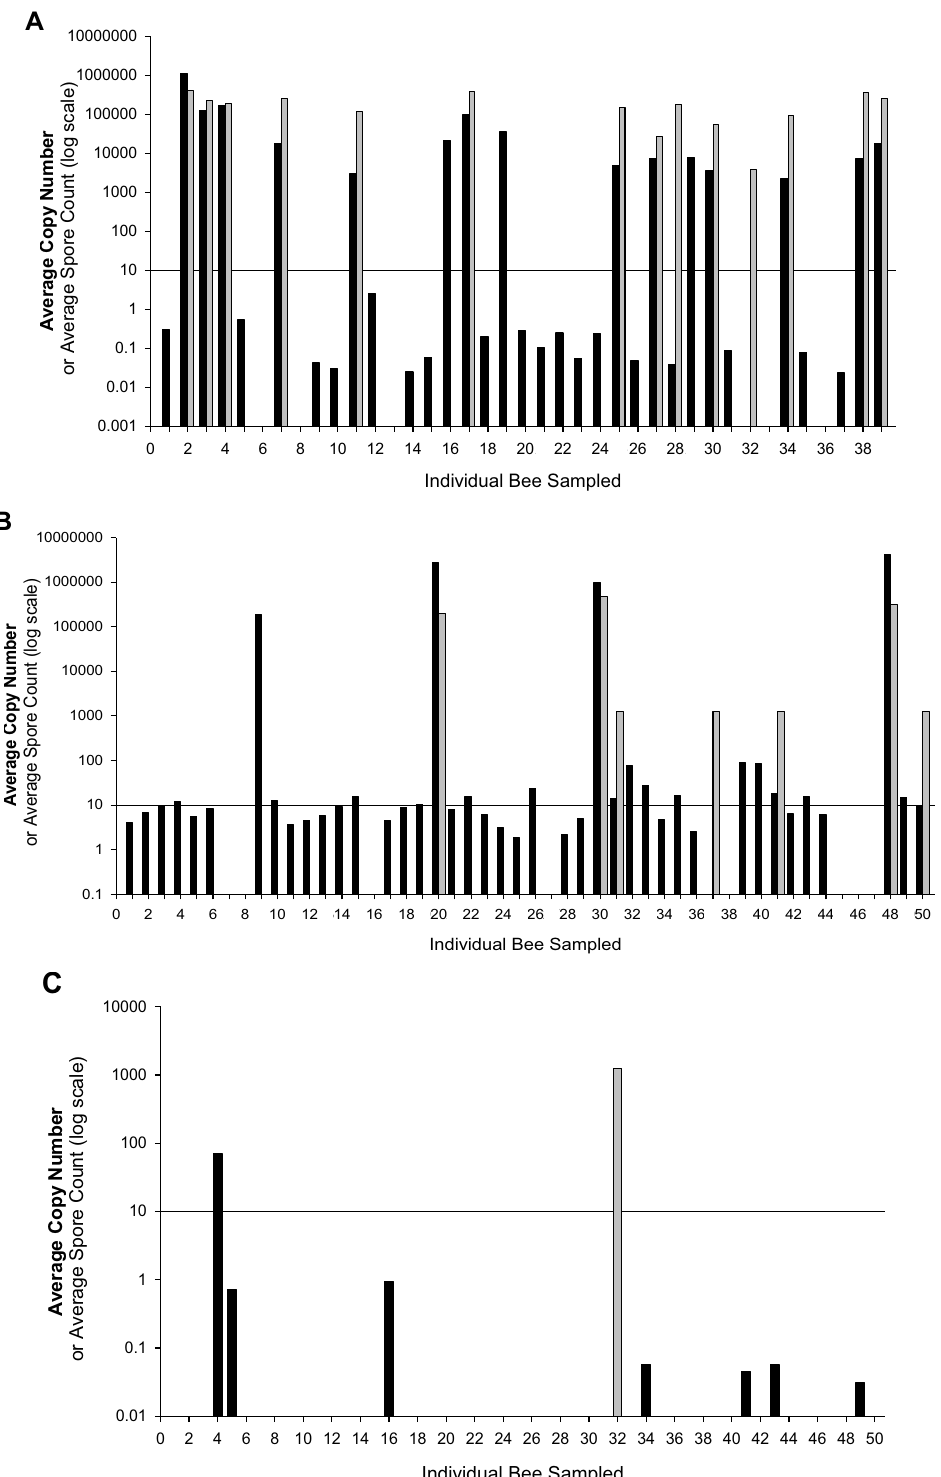
Figure 1. Variation in the mean number of N. ceranae DNA copies (in a standardized 50 ng sample/bee) and spore counts for the same individual bees. The line represents a cut-off point, 10 copies, at which we can reliably detect N. ceranae levels. Black bars represent the mean N. ceranae DNA copies from each bee sample while the gray bars represent the mean spore counts for the same bee. (a) Data from colony 3 in the spring (b) Data from colony 1 in the summer (c) Data from colony 3 in the fall.